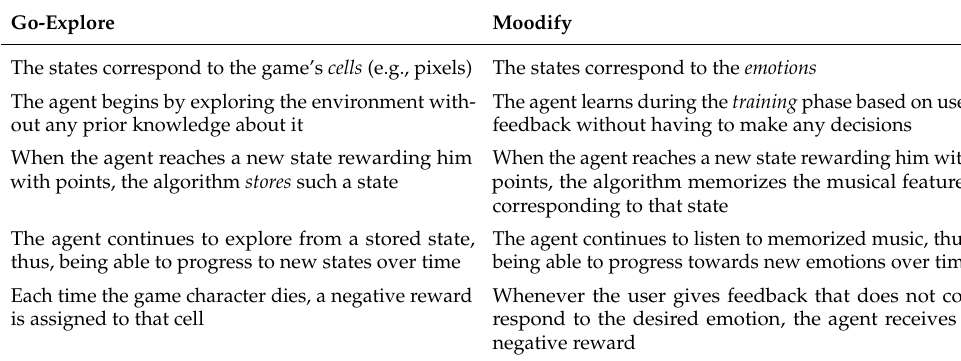
Table 3. From Go-Explore to Moodify: project